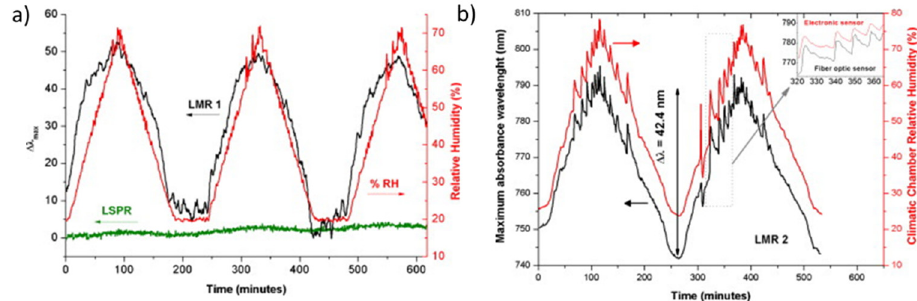
Figure 11. Evolution of the dynamic response of the optical fiber sensors composed of 25 bilayers ( a ) and 40 bilayers ( b ), respectively. Reprinted with permission of [52].